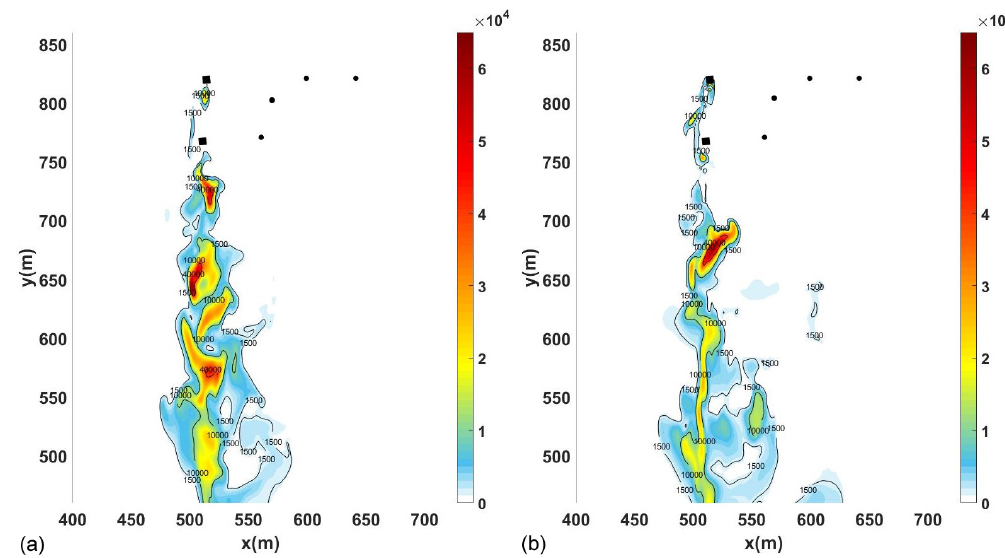
Figure 7. SO 2 instant concentration ( µ g/m 3 ) at 60 m above ground (10 m below emission). ( a ) Results obtained with caffa3d, and ( b ) with the GPU-using